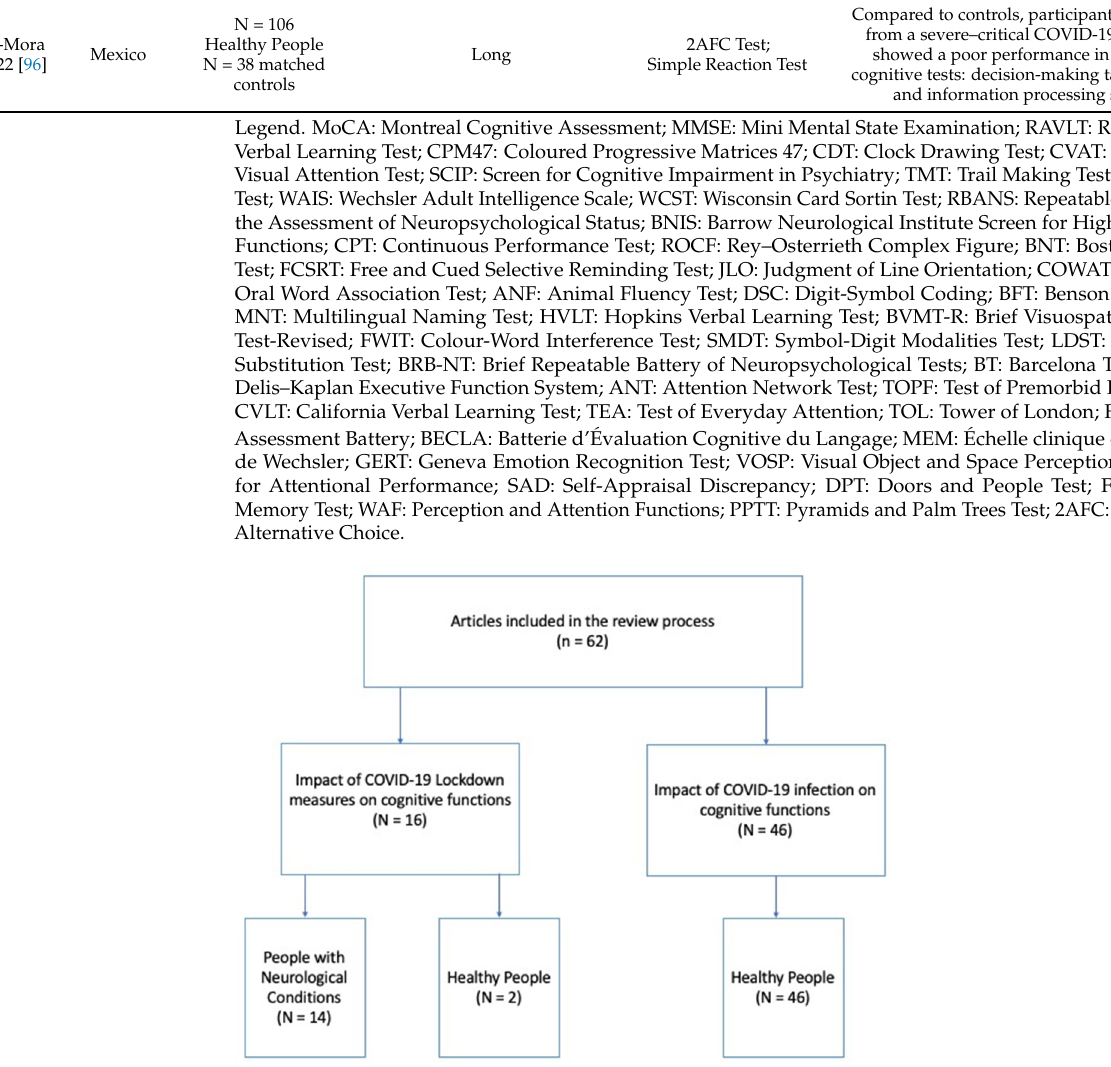
Figure 2. Articles included in the review process. Table 1. Summary of studies reporting the negative effects of COVID-19 lockdown measures on cognitive performance, respectively, in people with neurological conditions and healthy people for